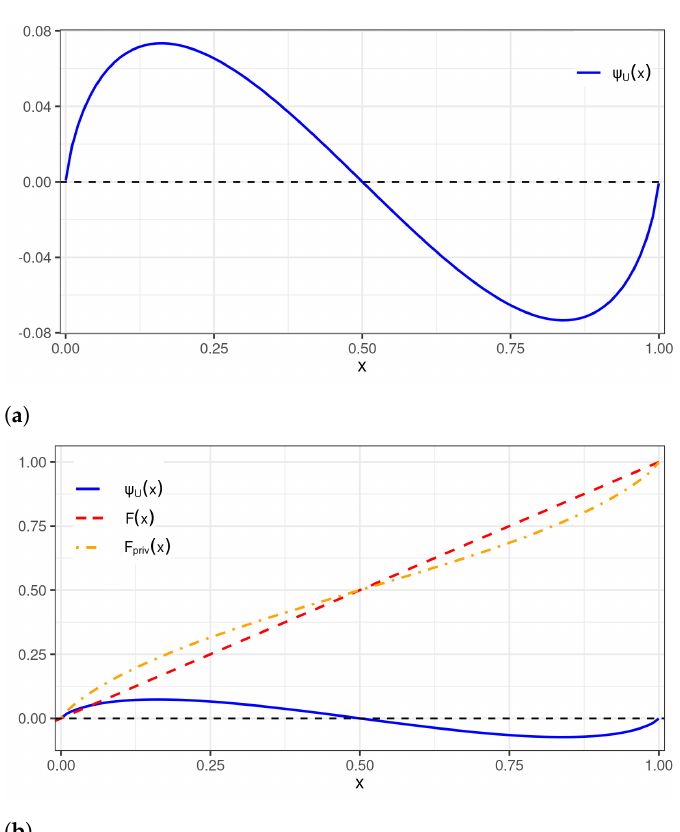
Figure 1. Plots of: ( a ) a wavelet perturbation to be applied to the U [ 0,1 ] distribution; and ( b ) wavelet perturbation (— blue), uniform (- - red), and perturbed uniform (- · - orange)